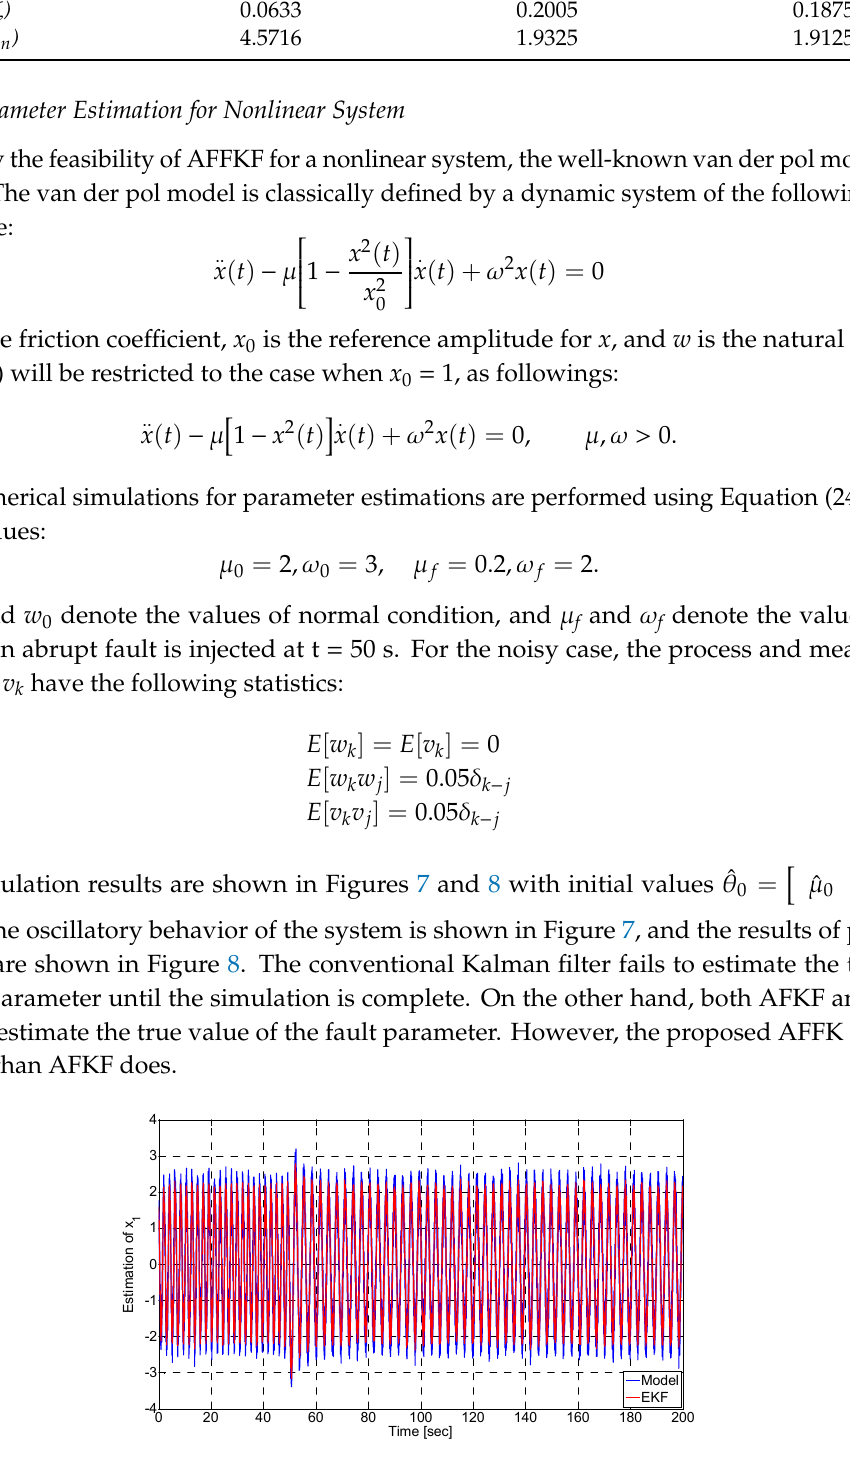
Figure 7. Estimated x and measurement y in v an der pol model.